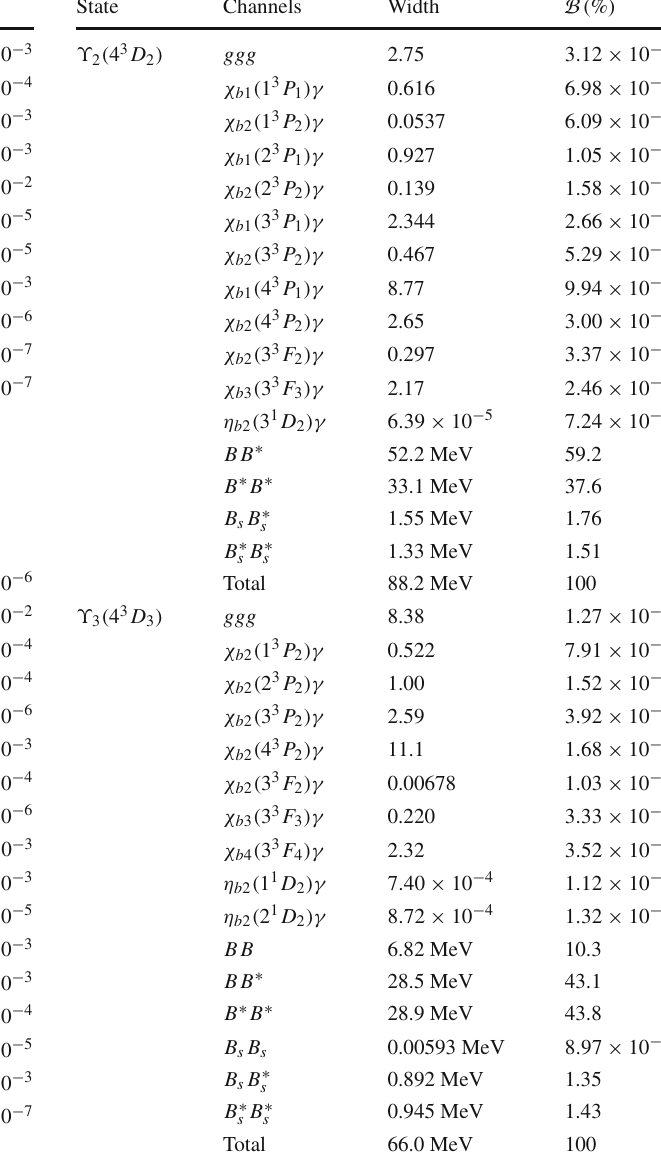
Table 29 Partial widths and branching ratios of OZI-allowed strong decay, annihilation decay, and radiative transition and total widths for 4 1 D 2 and 4 3 D 1 bottomonium states. The width results are in units of keV